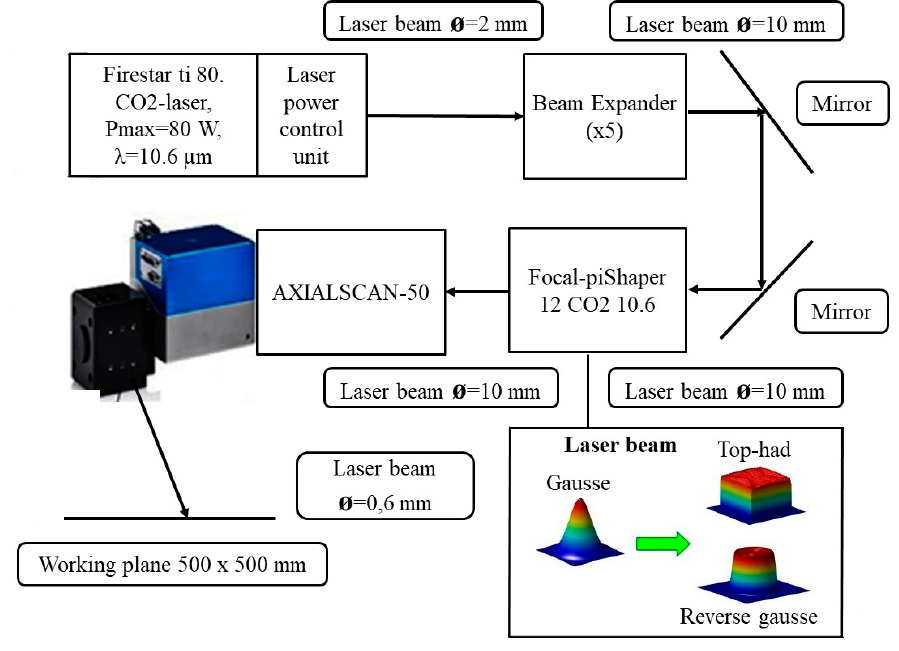
Figure 6. The laser-optical scheme of the SLS machine.